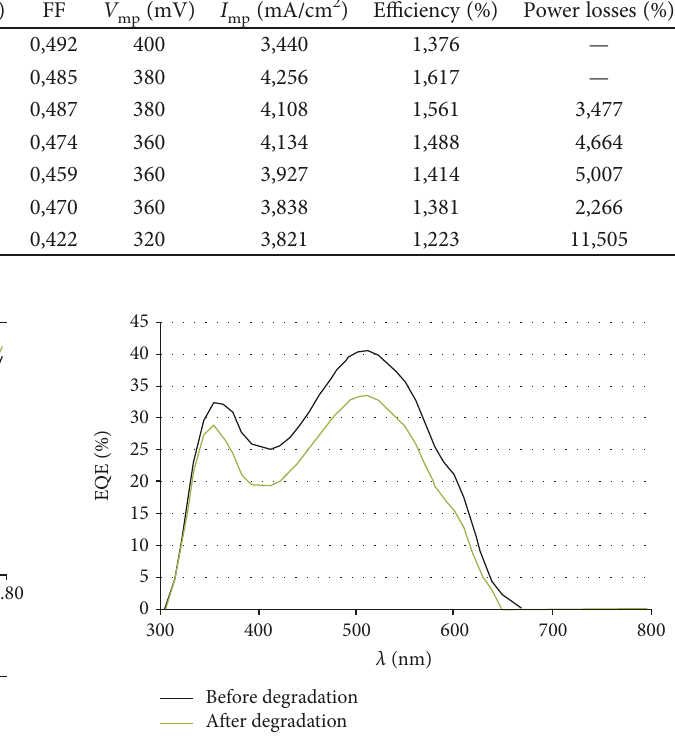
Figure 11: Device 5 fi nger 3 time-dependent voltage degradation EQE- λ